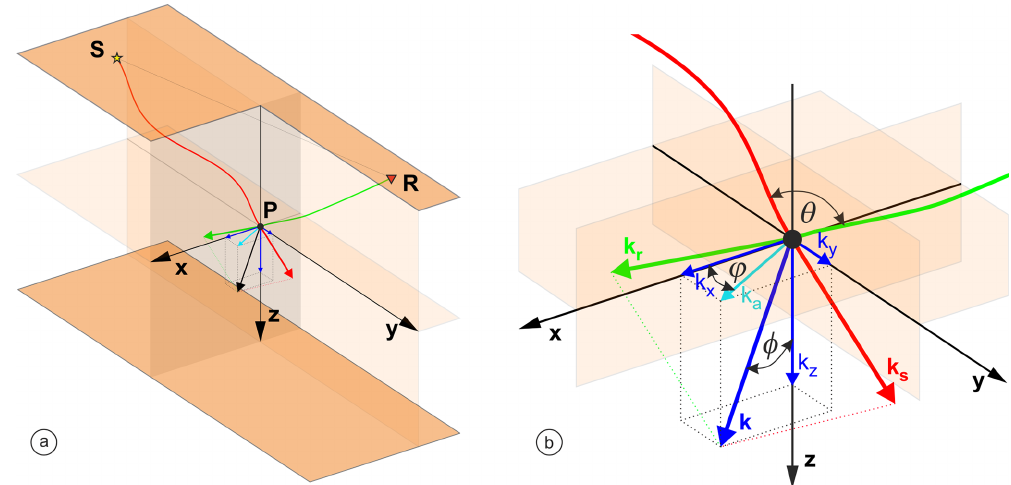
Figure 1. (a) Sketch of the single source/receiver ( S / R ) acquisition and the 3D wavenumber vector k mapped by FWI at the scattering point P . (b) Zoom on (a) . Local wavenumber vector k is a sum of the k s and k r vectors associated with the ray paths emerging from the source S and receiver R creating the scattering angle θ at the scattering point P . Dip and azimuth of the wavenumber vector k are defined by the φ and ϕ angles. The modulus of k is given by (λ/ 2 ) cos (θ/ 2 ) , where λ denotes the local wavelength (Miller et al., 1987; Wu and Toksöz, 1987). The range of k mapped at each point P by the acquisition gives the resolution with which the subsurface is reconstructed by